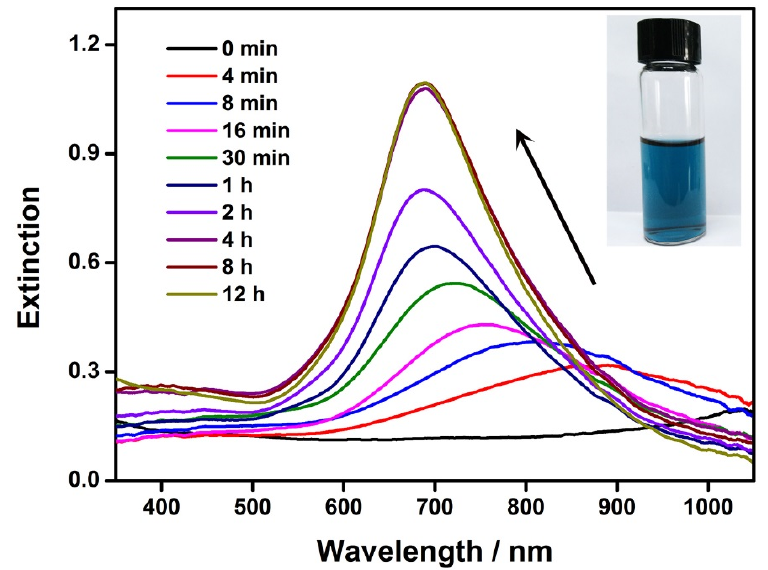
Figure 2. Evolution of the LSPR during the growth of the Au nanoplates. The UV–Vis spectra were recorded at varying reaction times. Inset: a photograph of the Au